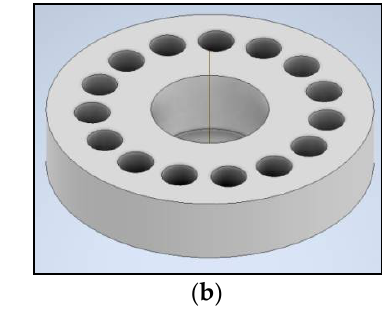
Figure 6. Picture showing stepper motors, globe valves, and solenoid valves. Figure 7. Designed components: cap ( a ); knob ( b ).